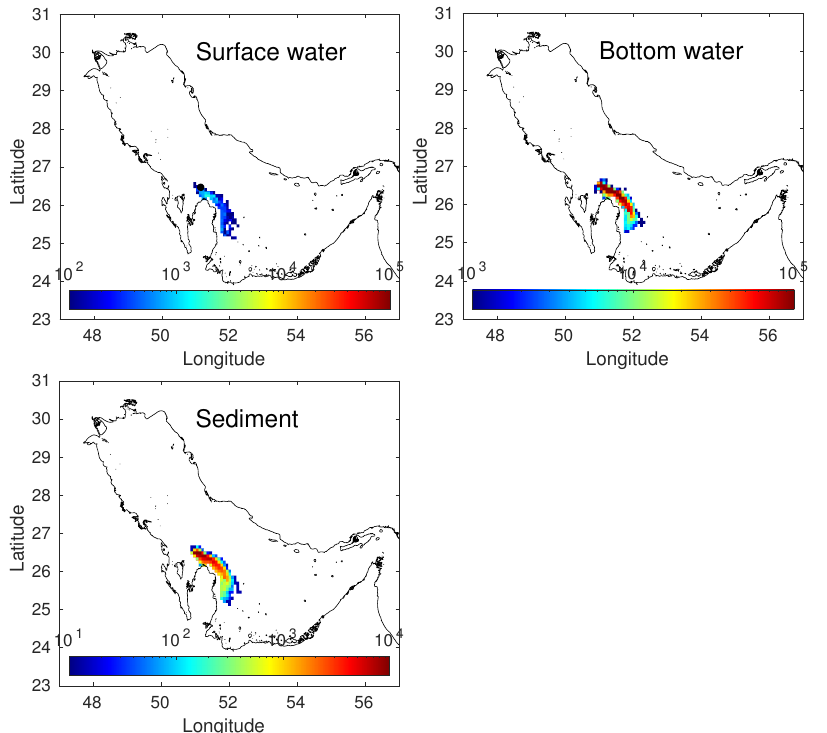
Figure 5. Calculated concentrations in the surface layer (units/m 3 ), inventory (units/m 2 ) in the bottom water layer and concentrations in sediments (units/kg) for the Hg release after 30 days. The black dot in the surface water map indicates the release point.